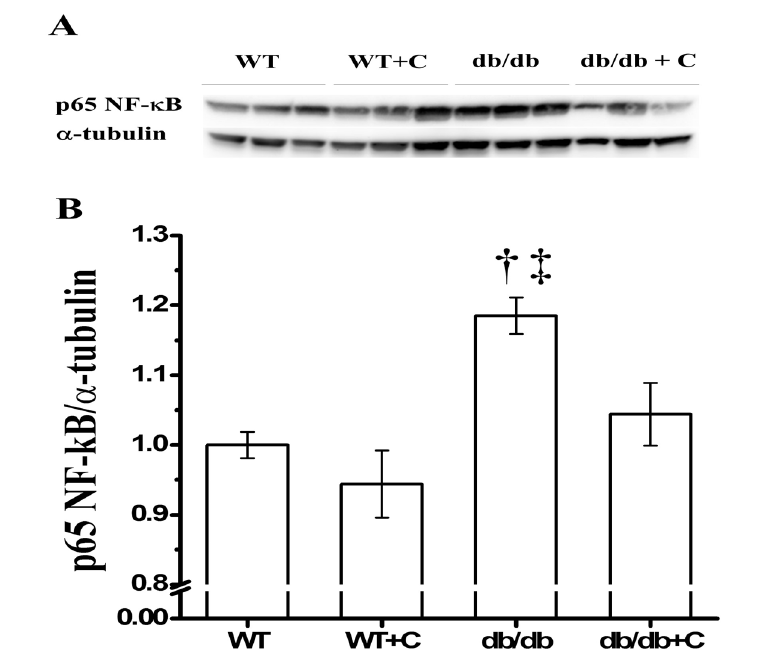
Figure 2. Effect of curcumin on NF- κ B expression in liver. ( A ) Representative western blot of the NF- κ B and α -tubulin. ( B ) Densitometry analysis of the NF- κ B/ α -tubulin ratio; † vs. WT and db/db+C, p < 0.05; ‡ vs. WT+C, p <